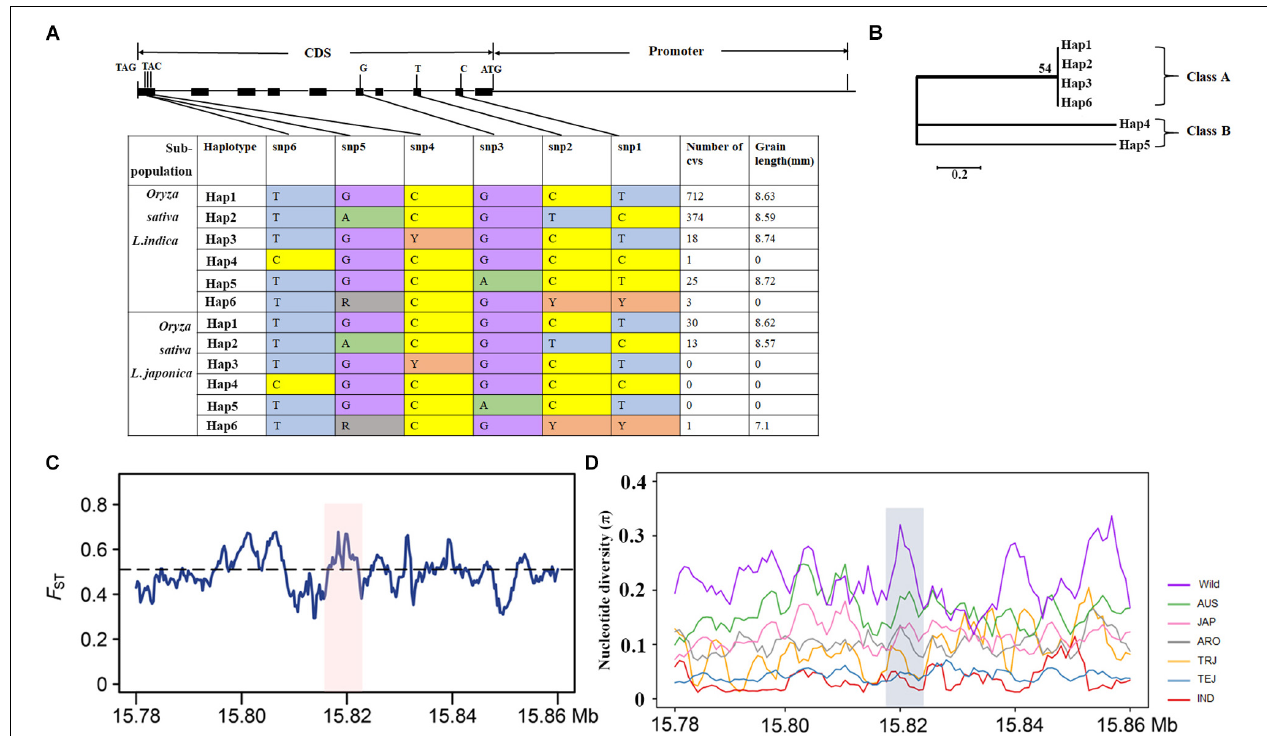
FIGURE 3 | Haplotypes and genomic differentiation of OsMKK3 . (A) Haplotype analysis of OsMKK3 . Gene structure and natural variation between alleles from NIP. (B) Cladogram of six haplotypes. (C) Genetic differentiation of OsMKK3 and major associated loci. Blue and green lines represent the F ST between indica and japonica . (D) Nucleotide diversity analysis in OsMKK3 and flanking regions ( ∼ 40 kb). TABLE 1 | The nucleotide diversity and Tajima’s D of OsMKK3 and its flanking regions. Region Parameter AUS (197) ARO (74)